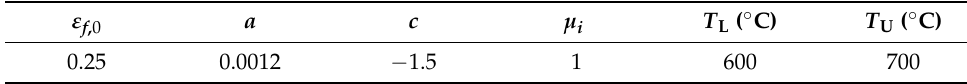
Table 5. Damage and failure parameters for Ti6Al4V alloy